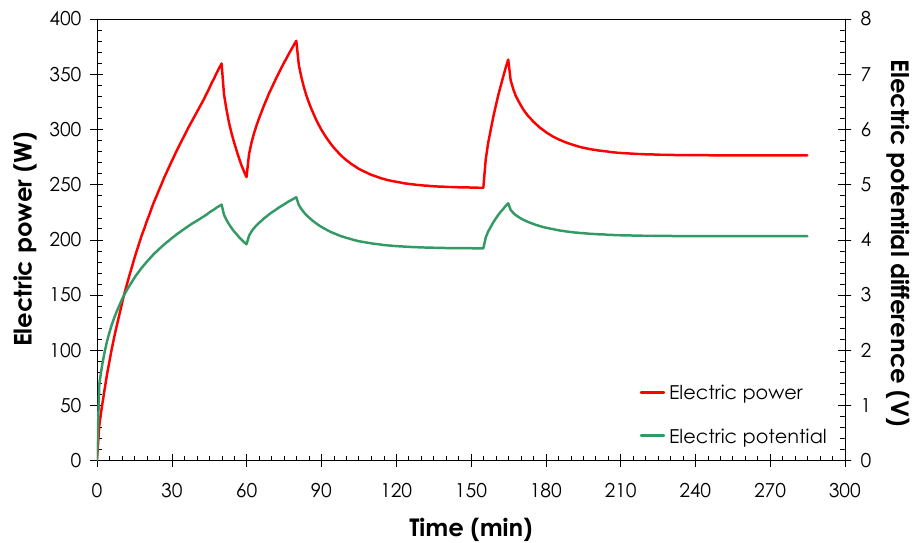
Figure 6. Evolutions of electric power and voltage difference needed to reach the required temperatures.